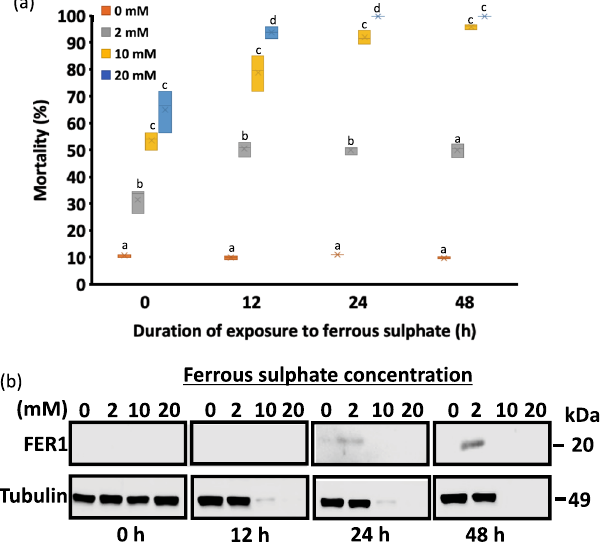
Figure 2. ( a ) Box and whisker plot showing the distribution of mortality in percentage of ISE6 cells exposed to different concentrations of ferrous sulphate. Two hundred fifty microliters of 1 × 10 6 cells/ml was transferred to a 48-well plate and incubated overnight. The next day, the media were replaced by ferrous sulphate–enriched media at different concentrations (0, 2, 10, and 20 mM). Mortality was checked at different time points (0, 12, 24, and 48 h) using Trypan blue stain. A one-way ANOVA with Bonferonni multiple comparison tests was performed (Tables S4 and S3). Time points with the same letter are not significantly different at P < 0.05. ( b ) Western blotting of ISE6 cells exposed to different concentrations of ferrous sulphate at different time points. Protein analysis of FER1 was observed using Western blotting. Anti-mouse tubulin was used as a loading control. Full length blots are presented in Fig. S4. The Western blotting results are representatives of three separate experiments. The data presented are results of three independent experiments with the Trypan blue staining performed in two technical replicates for each experiment.